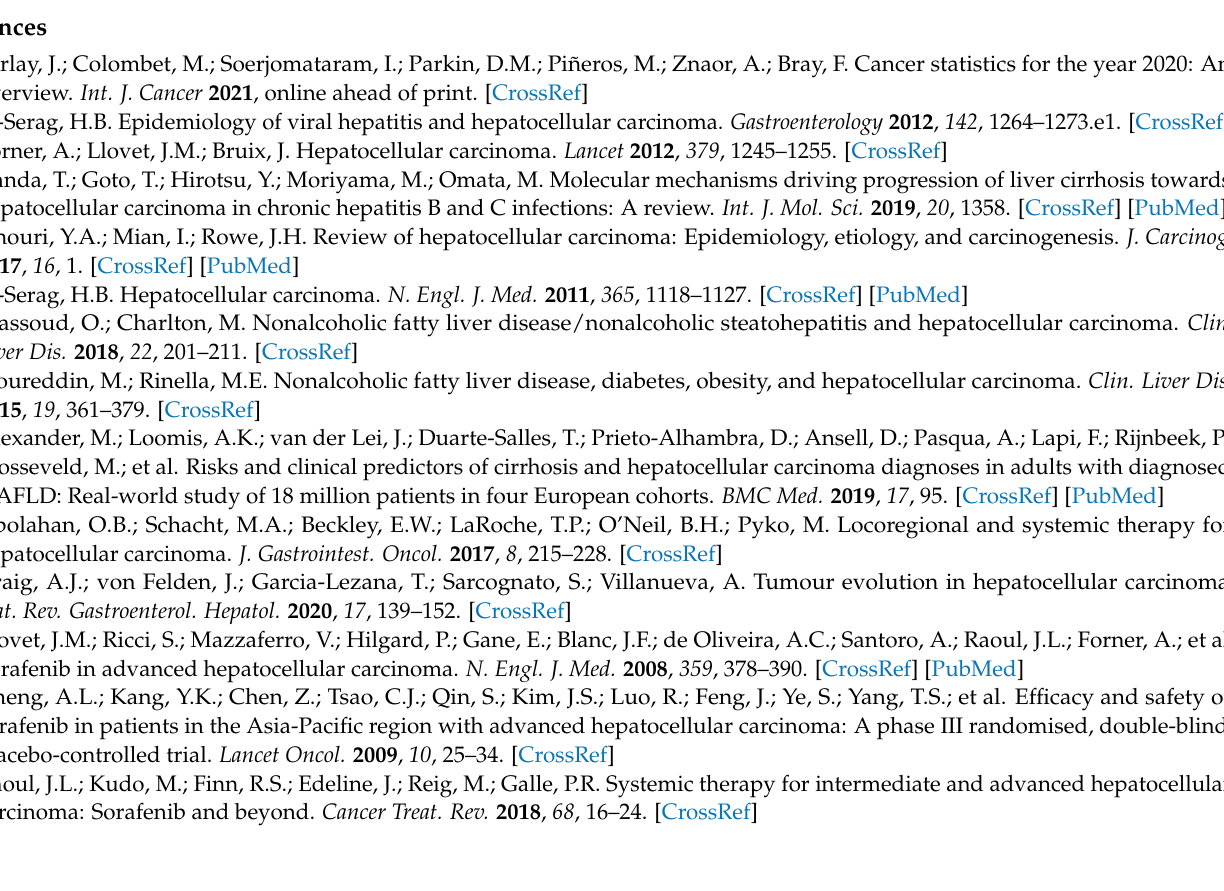
Table S3: Ongoing studies with checkpoint inhibitors in hepatocellular carcinoma in the preoperative or adjuvant